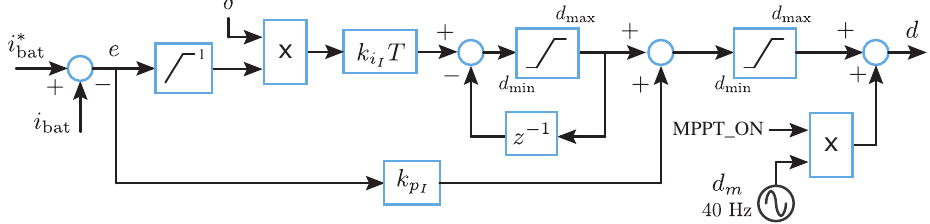
Figure 10. Proposed proportional-integral (PI) current control modification to achieve In-Cond